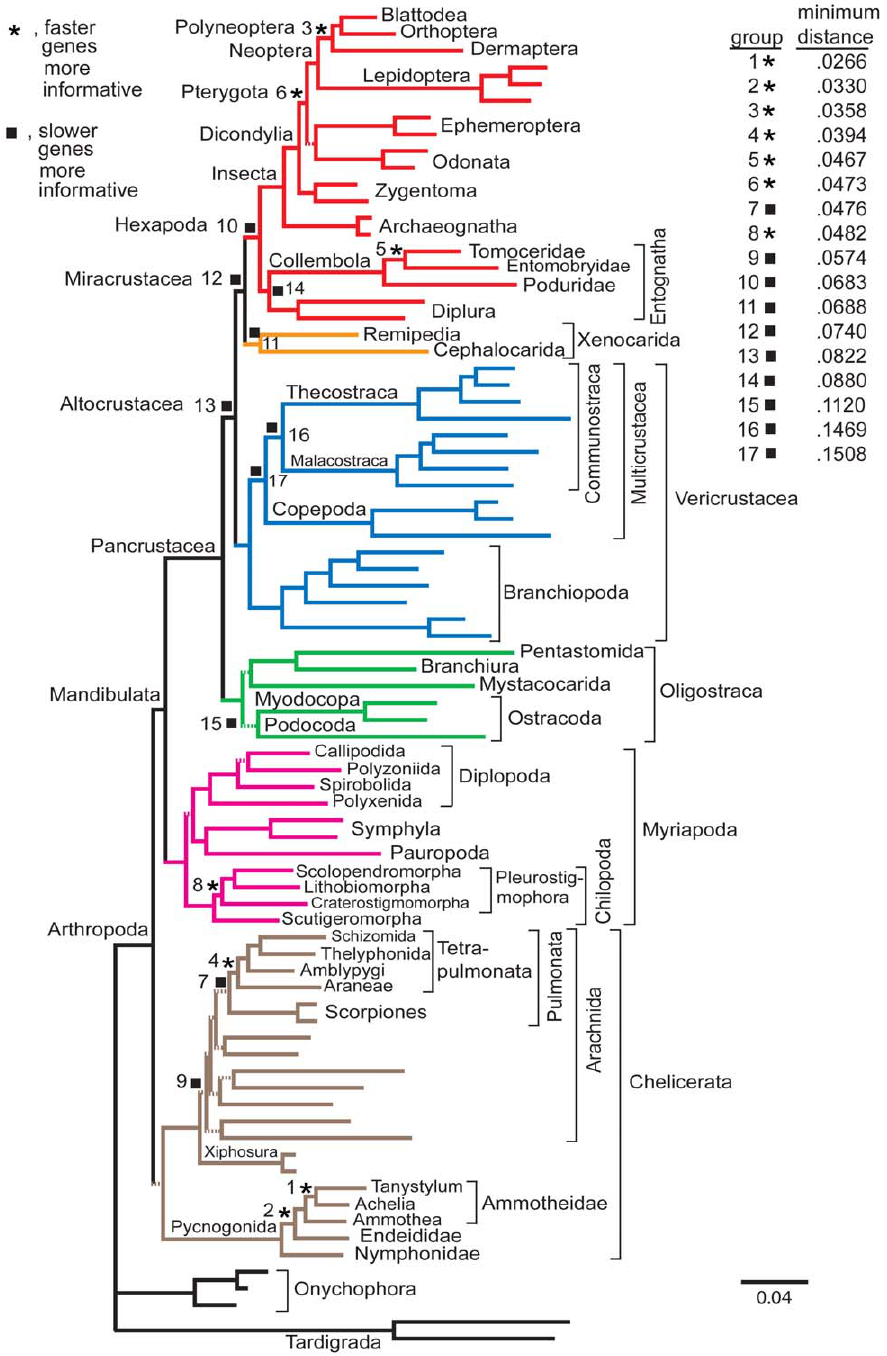
Figure 3. Phylogram of higher-level arthropod relationships based on likelihood analysis of aligned, concatenated nt123_degen1 sequences. The cladogenic relationships of 80 "panarthropod" taxa based on analysis of 68 gene segments are the same as those in Figure 1. Nodes with BP that are at least 25% higher with the faster genes than the slower genes are marked with an asterisk. Groups with BP that are at least 25% higher with the slower genes than with the faster genes are marked with a filled square. The shortest distance in number of substitutions / character from the base of a group to a terminal taxon in that group ("minimum distance" in inserted table) was calculated by summing the likelihood branch lengths. Groups are numbered from those with the shortest distance to a terminal (no. 1= Tanystylum + Achelia ) to those with the longest distance (no. 17= Multicrustacea). doi:10.1371/journal.pone.0023408.g003 N making them uninformative), and the resulting nt3_4foldsynon In order to restrict the analysis almost entirely to synonymous change, all character states at nt3 positions that do not encode a data matrix was analyzed (Table 4, Figure 8). Under these fourfold synonymous codon were fully degenerated (i.e., coded as conditions, only 10 nodes in agreement with nt123_degen1 are